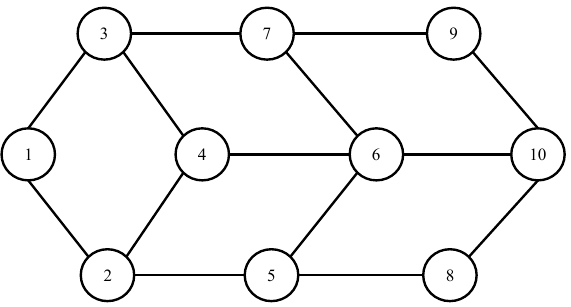
Figure 4. Network topology of edge servers in our simulation. Table 1. Task parameters in the simulation.